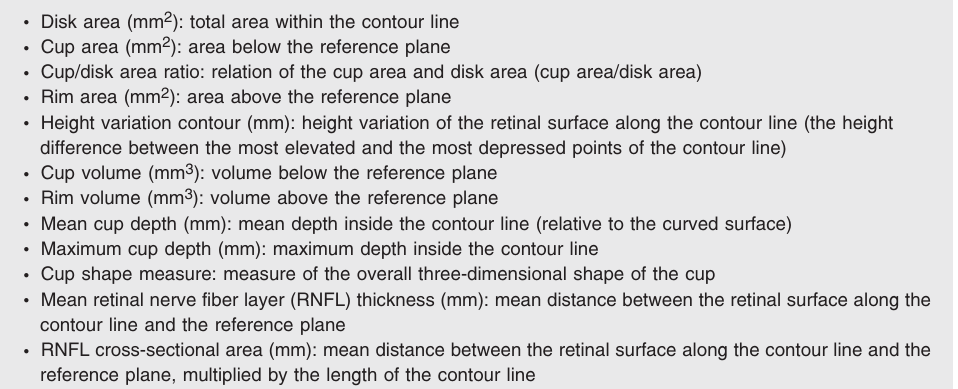
Table 1. Heidelberg retinal tomogram parameters included in the analysis. · Disk area (mm 2 ): total area within the contour line · Cup area (mm 2 ): area below the reference plane · Cup/disk area ratio: relation of the cup area and disk area (cup area/disk area) · Rim area (mm 2 ): area above the reference plane · Height variation contour (mm): height variation of the retinal surface along the contour line (the height difference between the most elevated and the most depressed points of the contour line) · Cup volume (mm 3 ): volume below the reference plane · Rim volume (mm 3 ): volume above the reference plane · Mean cup depth (mm): mean depth inside the contour line (relative to the curved surface) · Maximum cup depth (mm): maximum depth inside the contour line · Cup shape measure: measure of the overall three-dimensional shape of the cup · Mean retinal nerve fiber layer (RNFL) thickness (mm): mean distance between the retinal surface along the contour line and the reference plane · RNFL cross-sectional area (mm): mean distance between the retinal surface along the contour line and the reference plane, multiplied by the length of the contour